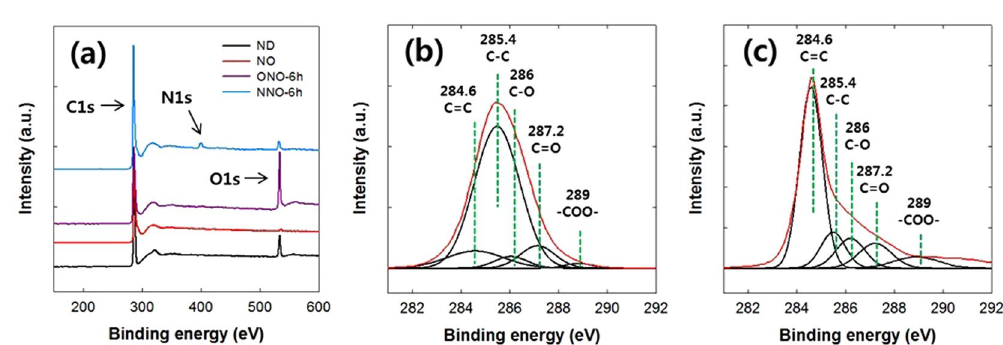
Figure 4. ( a ) XPS wide scan spectra of the ND, NO, ONO-6h, and NNO-6h samples, and ( b ) curve fitting of the C1s peak in the ND and ( c ) that of the C1s peak in the